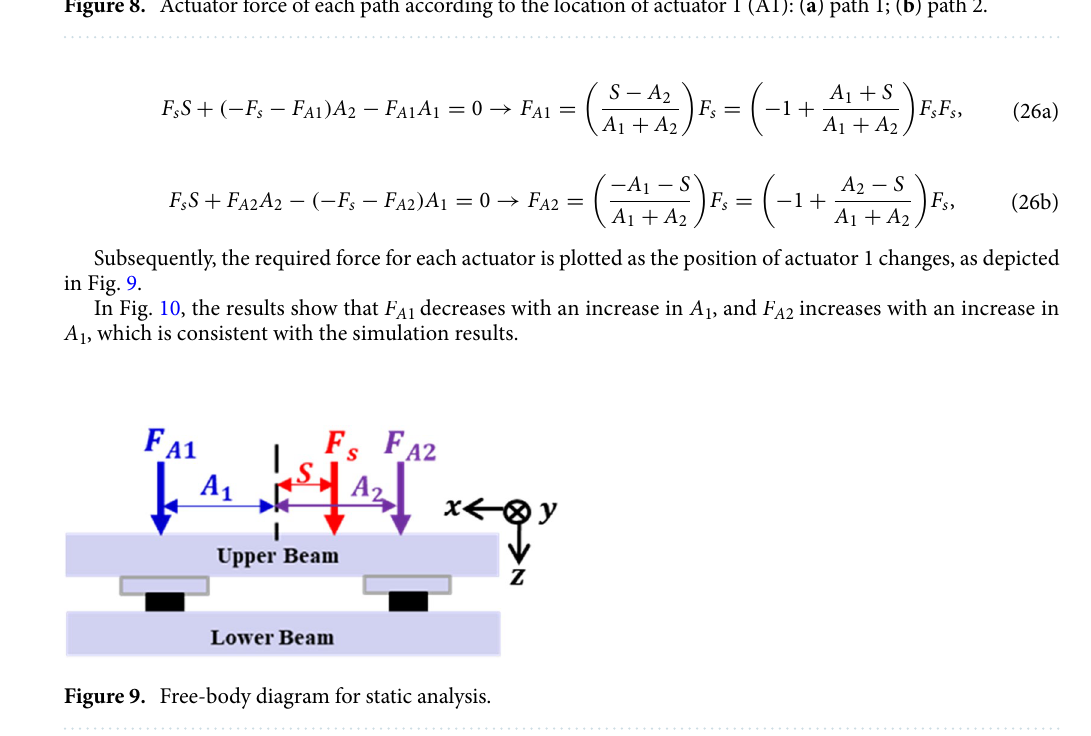
Figure 8. Actuator force of each path according to the location of actuator 1 (A1): ( a ) path 1; ( b ) path 2.